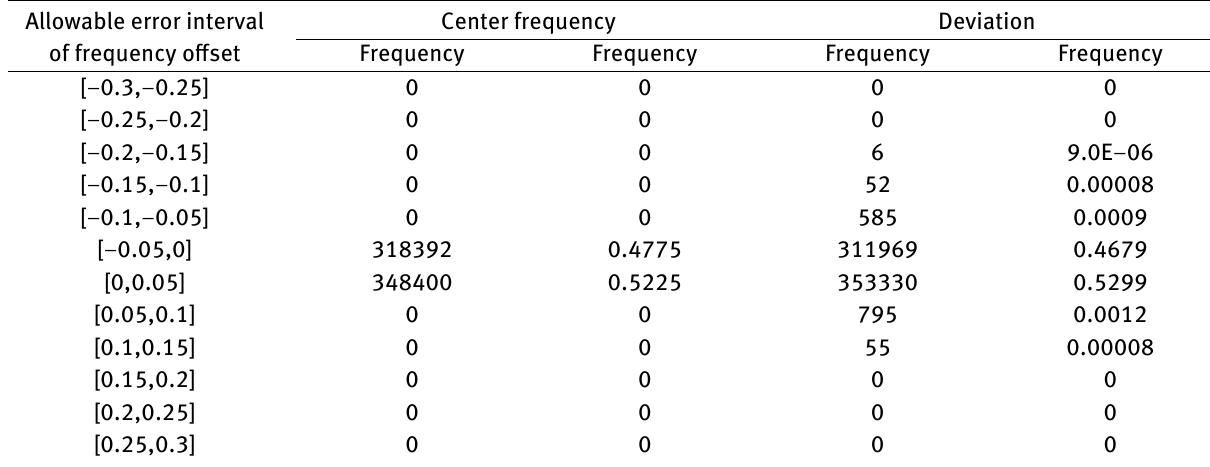
Table 5: Statistical results of 666,792 experiments of ZPW-2000 center frequency and frequency offset calculation errors Allowable error